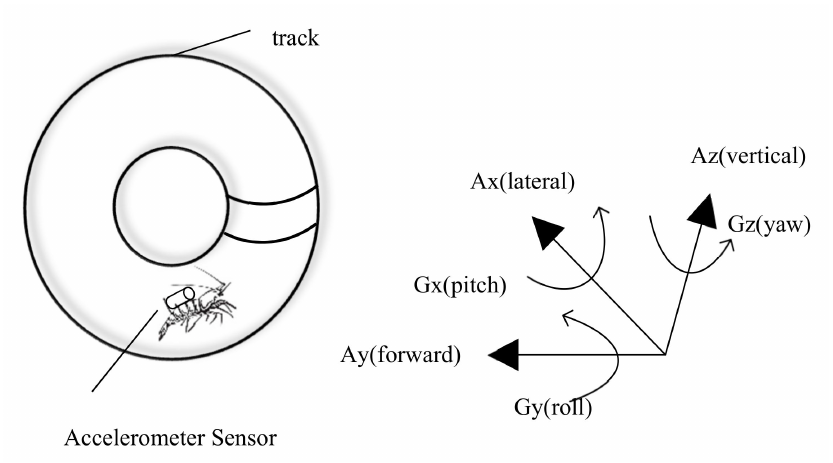
Figure 4. Crustacean behavior recognition based on an